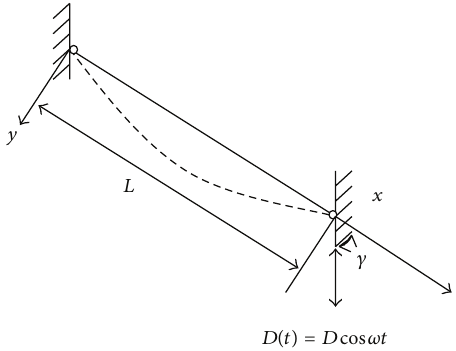
Figure 1: Dynamical modules of